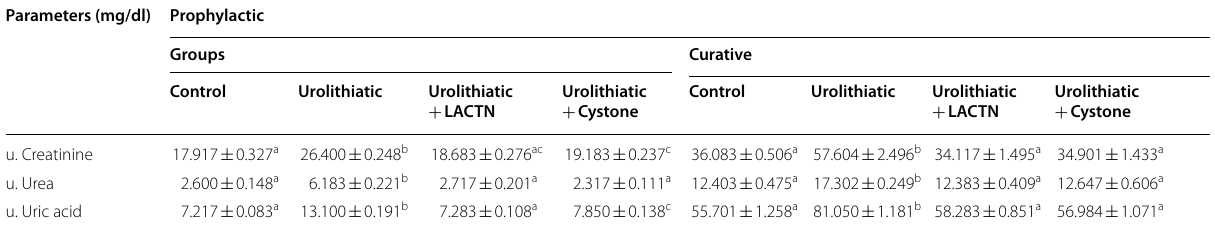
Values are expressed as mean SEM ( n 6). ANOVA post hoc with Duncan’s test was performed to compare between groups. Values with different row superscript ± = letters of the same regimen are significantly different ( P < 0.05)